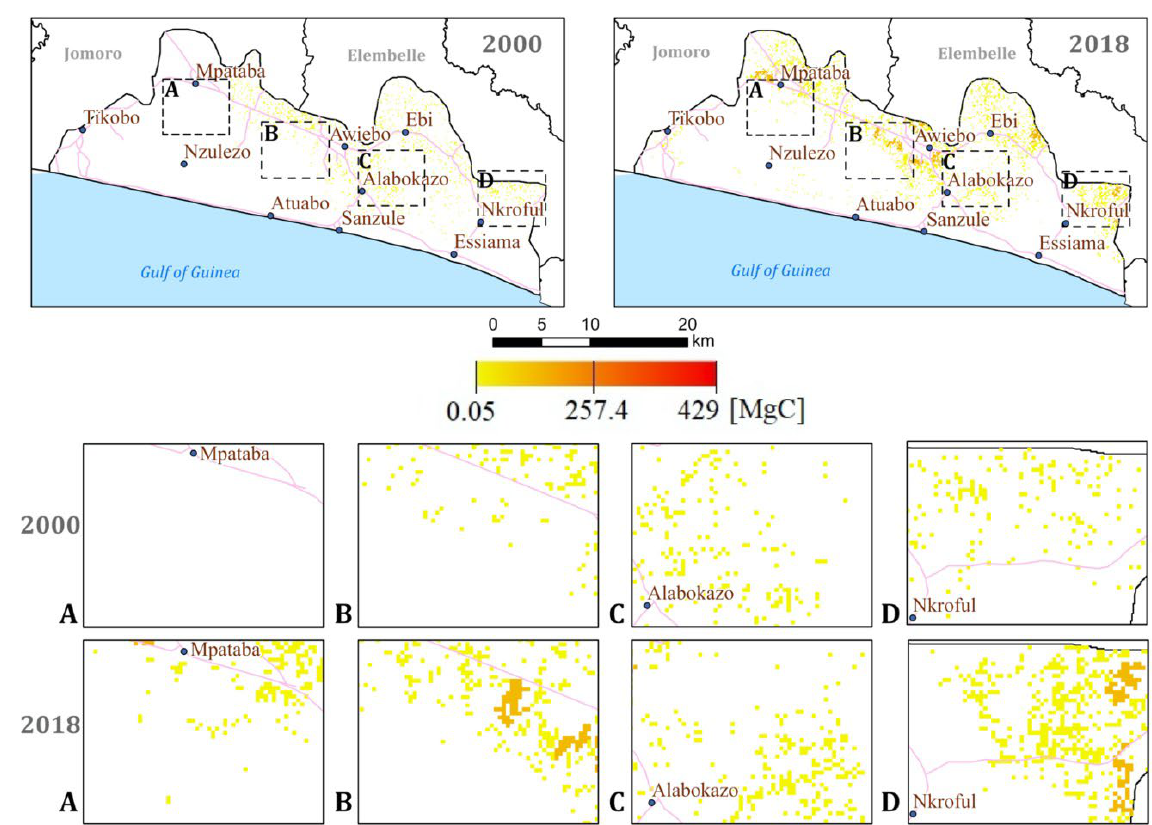
Figure 8. Quantities and distribution of aboveground carbon stored in rubber plantation across the landscape in 2000 and 2018; ( A – D ) compares the spatial and temporal distribution of aboveground rubber carbon storage potential of segments of the landscape.